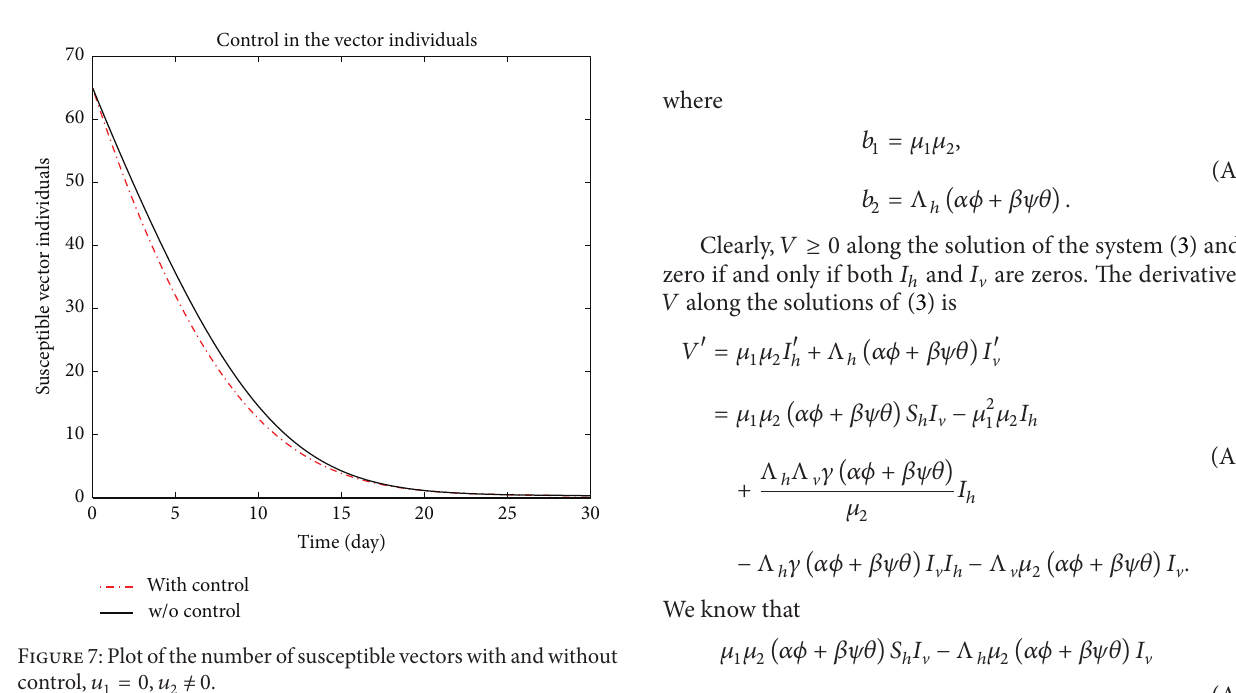
Figure 8: Plot of the number of infected vectors with and without control, 𝑢 1 = 0 , 𝑢 2 ̸=0